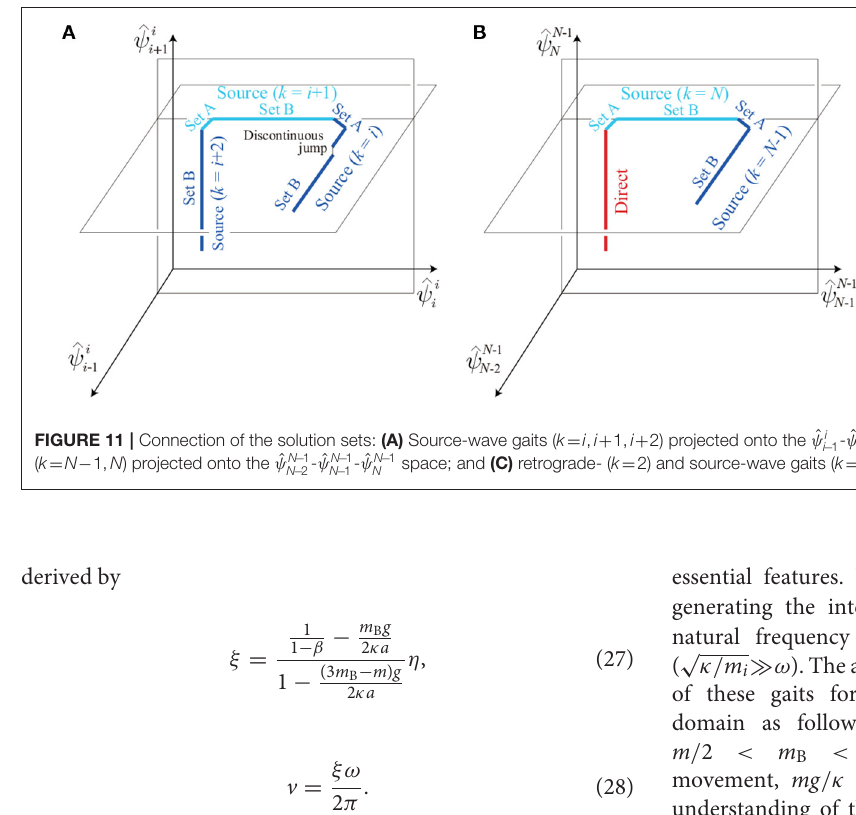
- ˆ ψ N − 1 N space; and (C) retrograde- ( k - ˆ ψ N − 1 N − 1 − 2